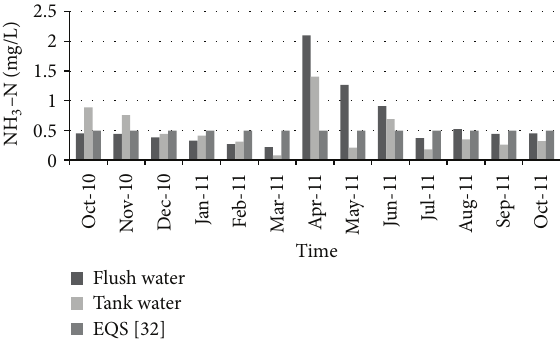
Figure 14: Variation of NH 3 –N over time.